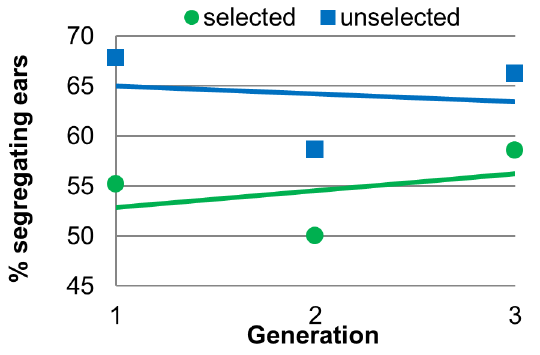
Fig 7. Effect of selection on percentage of segregating ears. Data points are percentage of segregating ears versus generation, shown with linear regression trend lines. The equations of the lines for selected and unselected populations are y = 1.6691x + 51.223 (R 2 = 0.1515) and y = -0.7808x + 65.75 (R 2 = 0.0251) respectively. There is significant deviation from the expected 50% segregating ears in the unselected populations, but not in the selected populations ( α (cid:2)